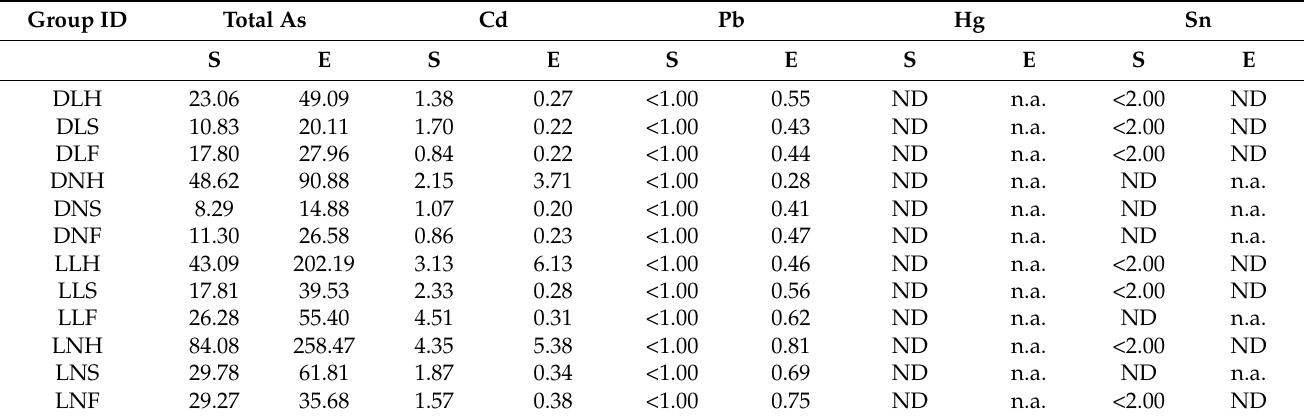
Table 6. Heavy metal content (Total As, Cd, Pb, Hg, and Sn) of seaweed samples (S) and derived PHLE extracts (E) expressed as mg/kg of dry weight. Data are means of two